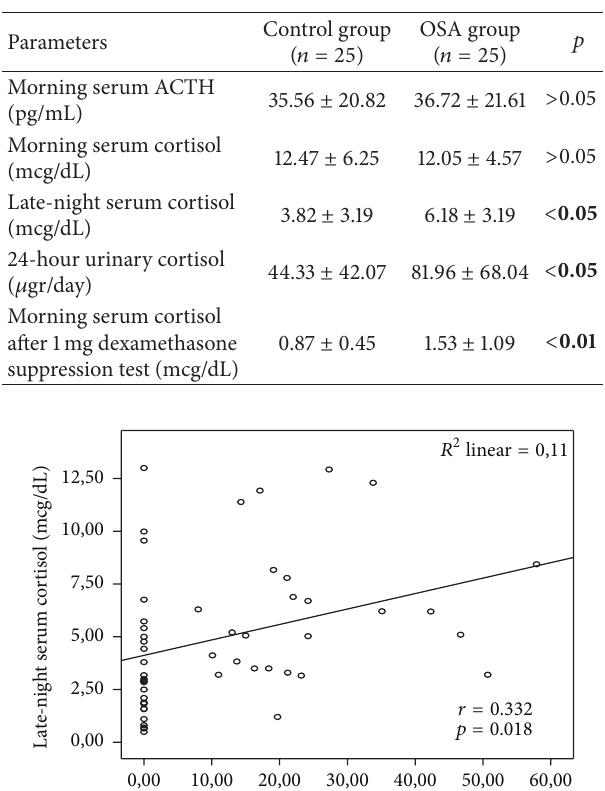
Table 3: ACTH and cortisol levels in control group versus OSA group.